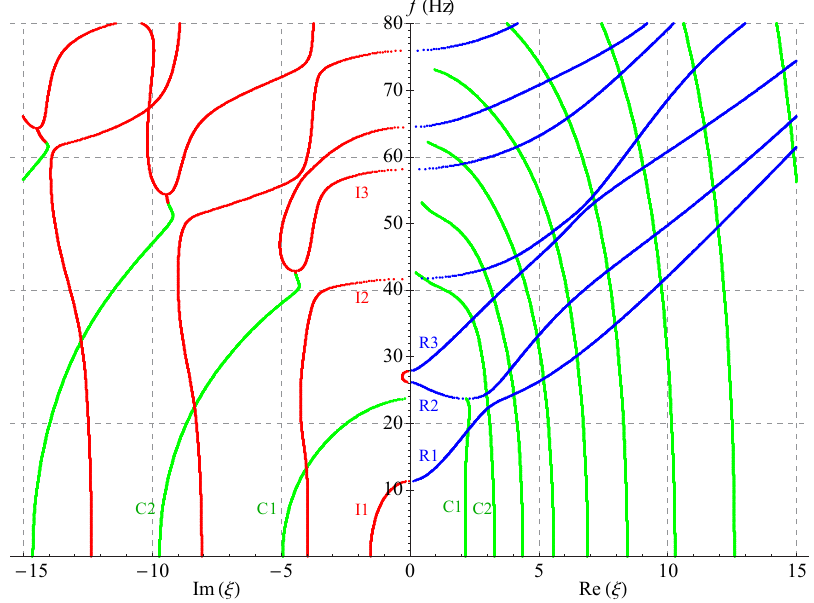
Figure 7. Two-dimensional full frequency spectra without considering magnetic field ( n =